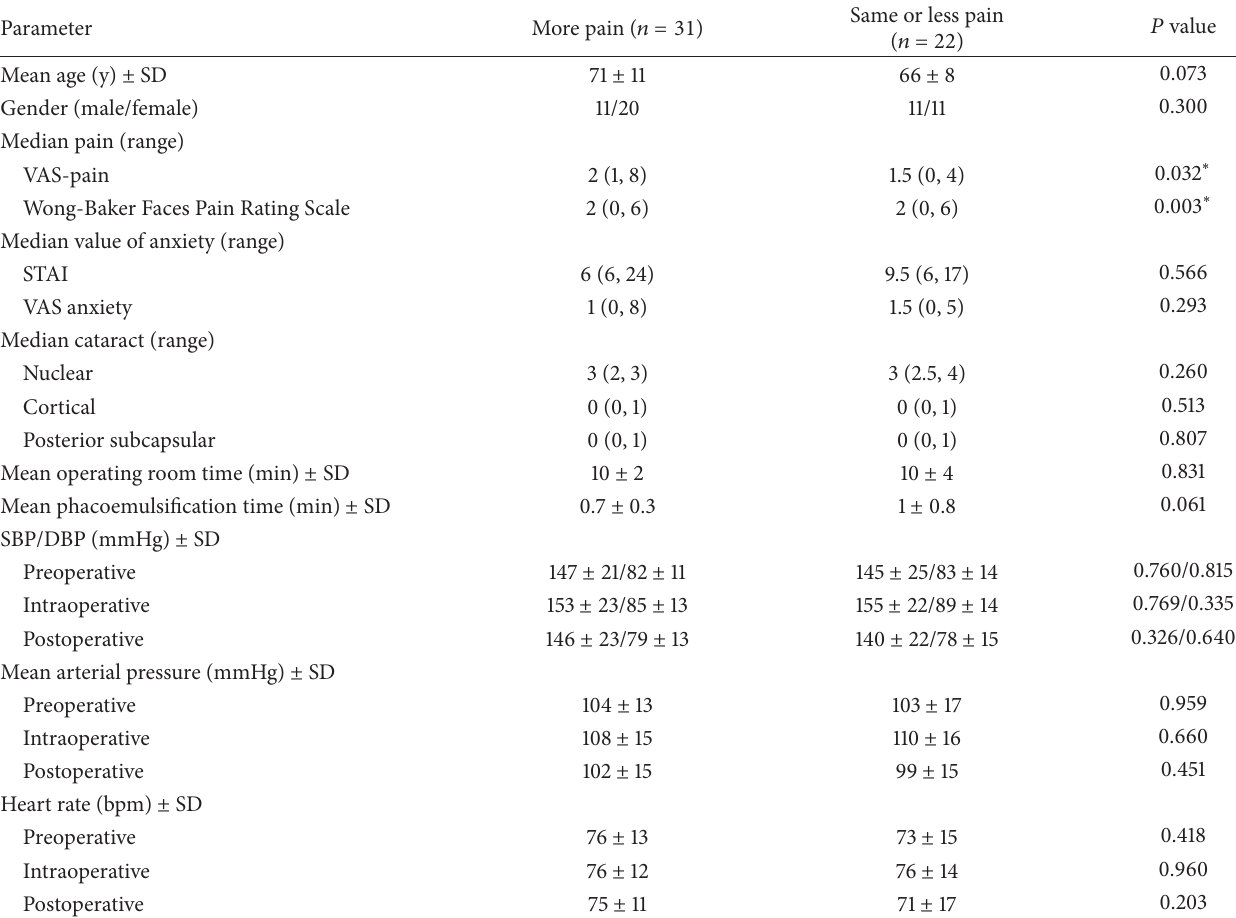
Table 3: Differences between two subgroups of patients who underwent bilateral sequential cataract